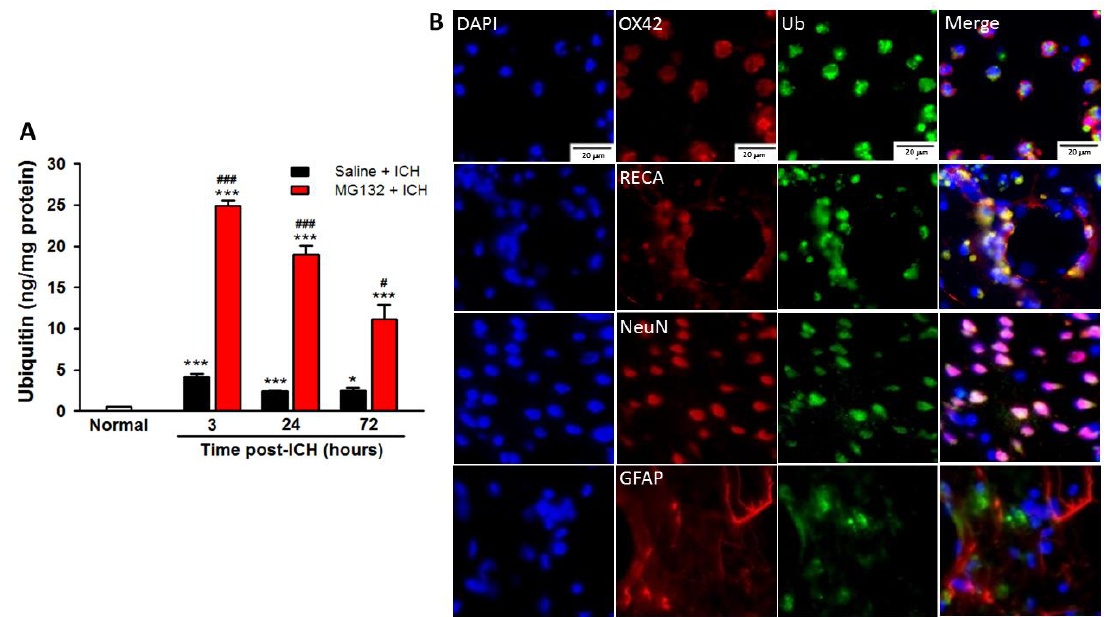
Figure 2. Expression of ubiquitinated protein in ICH injury striatum. Ubiquitin protein levels evaluated by ubiquitin competitive enzyme-linked immunosorbent assay at normal, 3, 24, and 72 h post-ICH injury ( A ). Rat brains were stained for ubiquitin (green) and dual stained with OX-42 (anti-CD11b/c; microglia, red), RECA (anti-rat endothelial cells antigen; vascular endothelial cells, red), NeuN (anti-neuronal nuclei; neuron, red) and GFAP (anti-glial fibrillary acidic protein; astrocyte, red) in the ipsilateral striatal (3 h post-ICH) ( B ). Value are indicated by means ± SEM; n = 6 each group, * p < 0.05; *** p < 0.001; compared to normal group; # p < 0.05; ### p < 0.001; compared to Saline + ICH group, respectively.